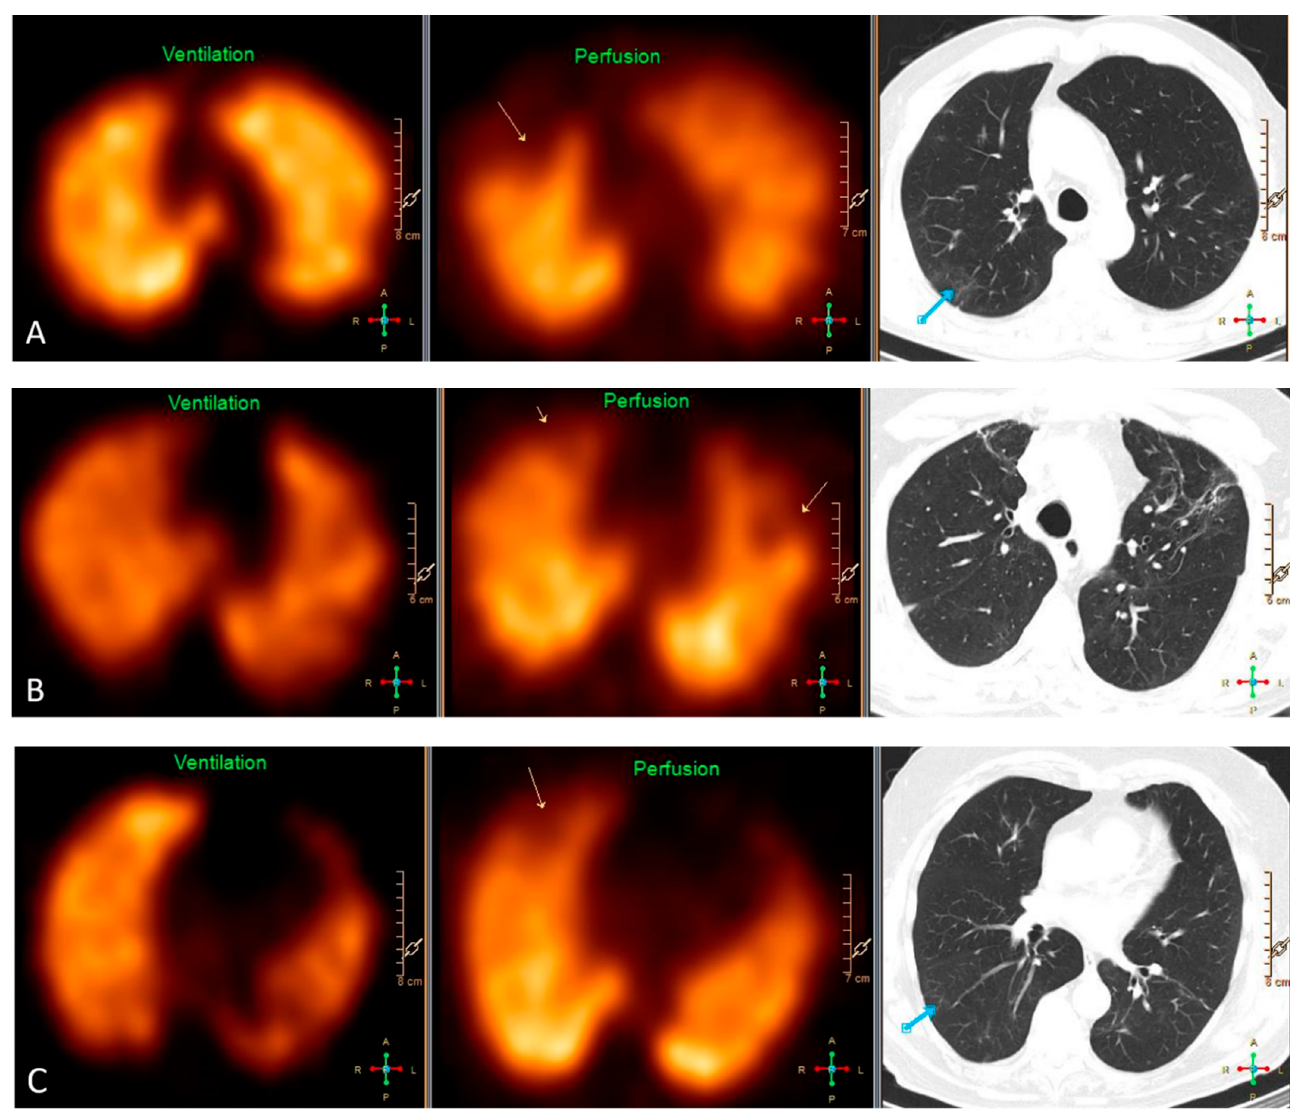
Figure 2. Representative findings on VQ SPECT and HRCT of three patients. ( A ) Pulmonary embolism in the right upper lobe causing a segmental mismatched perfusion defect on SPECT (yellow arrow) without any abnormality in the same area on HRCT. The blue arrow depicts ground-glass opacities dorsally in the right upper lobe without any defect on SPECT. ( B ) HRCT shows signs of fibrosis in the upper lobes causing partially mismatched subsegmental perfusion defects on SPECT (yellow arrows). ( C ) Pulmonary embolism in the right upper lobe causing a subsegmental mismatched perfusion defect on SPECT (yellow arrow) without any abnormality on HRCT in the same area. The blue arrow depicts discrete ground-glass opacities and signs of hypoventilation dorsally in the upper part of the right lower lobe.